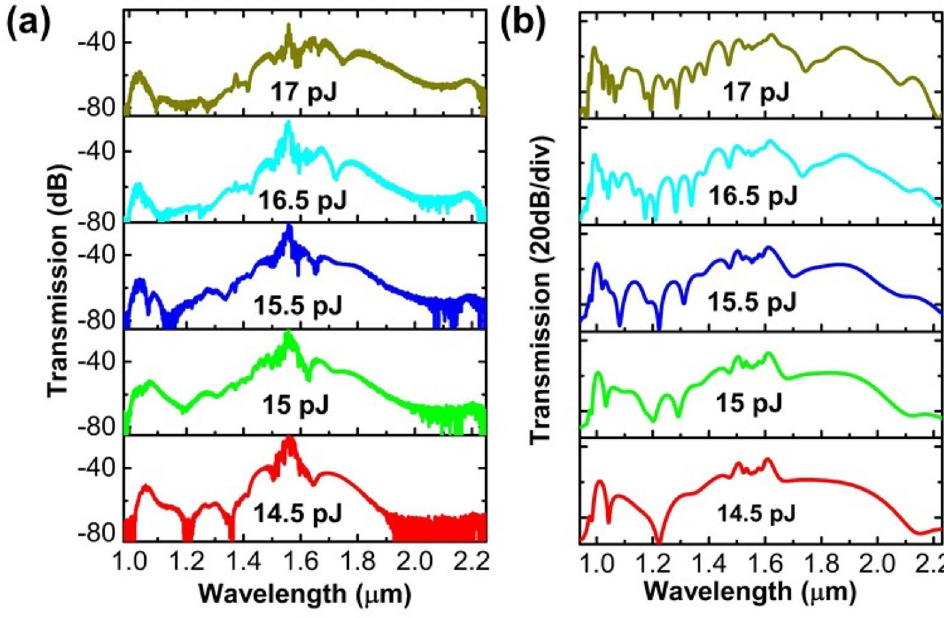
Figure 2. Measured ( a ) and simulated ( b ) output spectra at various pulse energies coupled into the USRN waveguide.